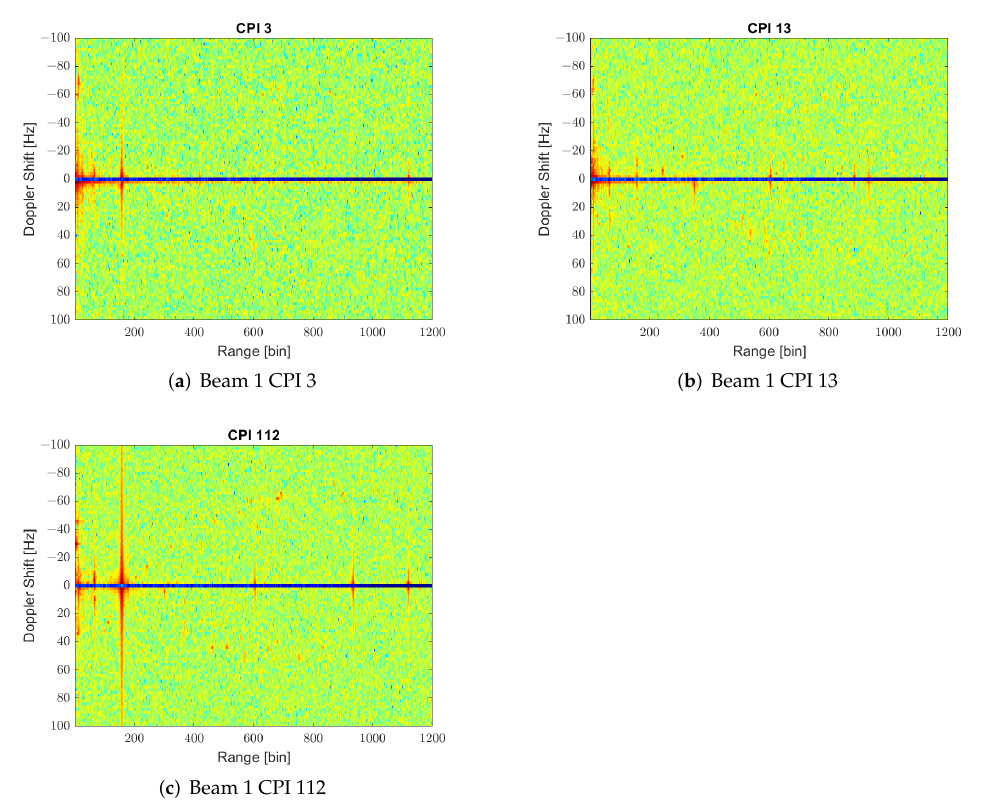
Figure 8. RD maps of different CPIs showing the variance in interference sources through the acquisition